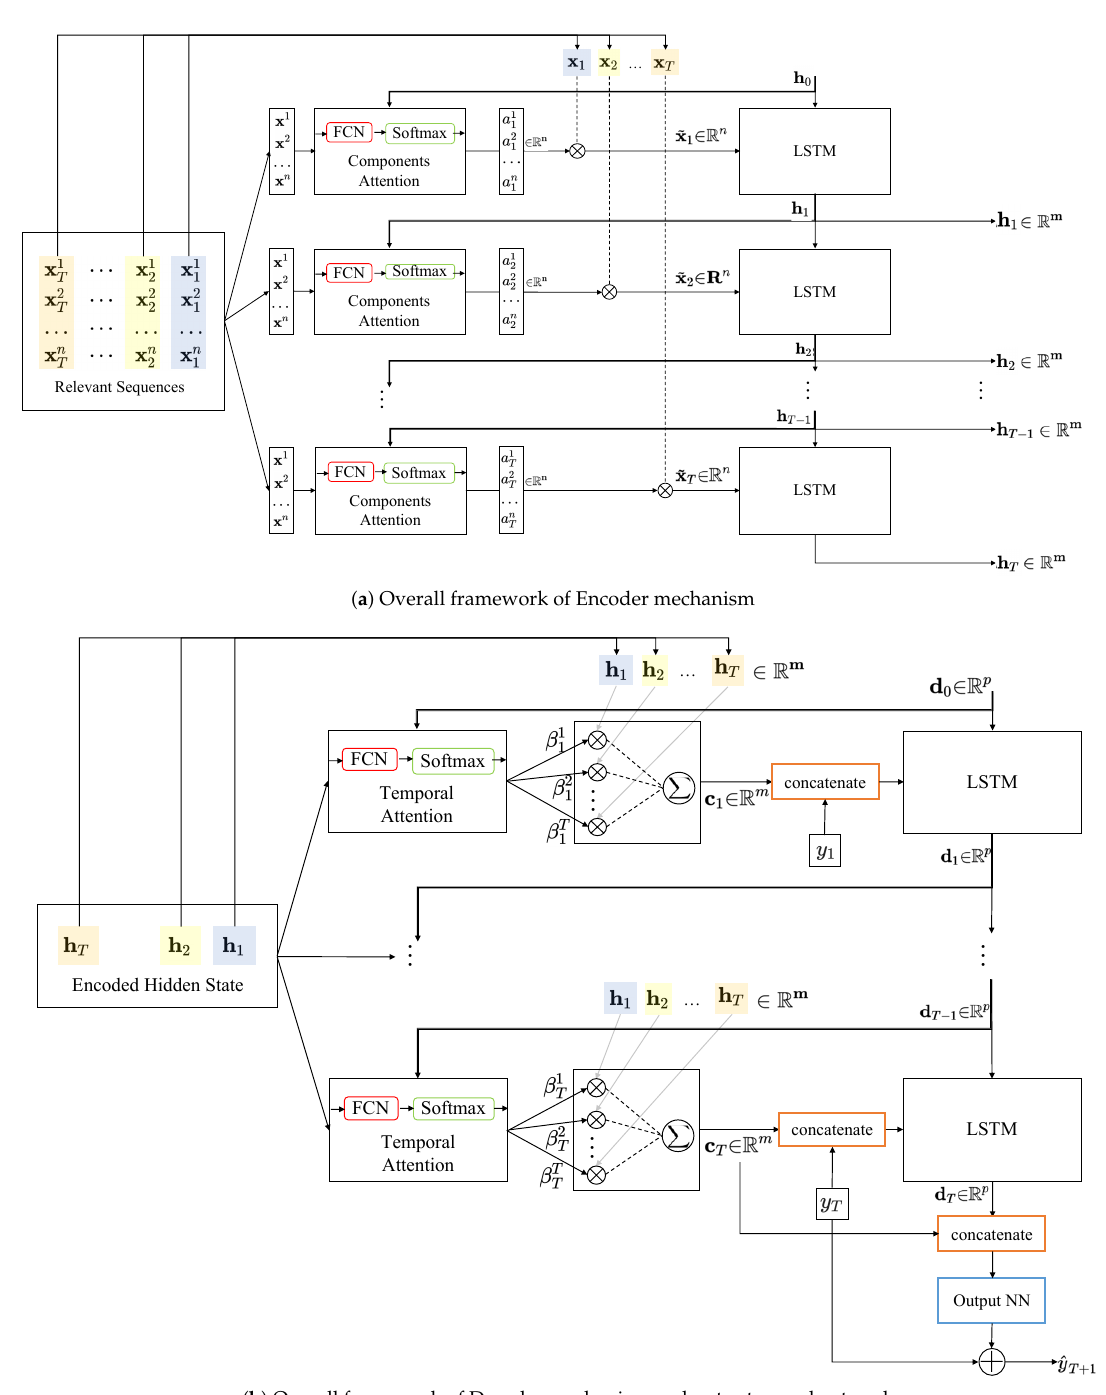
Figure 3. The proposed model consists of three parts: encoder, decoder, and a fully connected neural network for final predicting. The output of the encoder mechanism is the input of the decoder mechanism. Encoder is employed to embed the history series to encoded features h t , which are inferred from a Lstm mechanism in encoder module. Then, the encoded features will be decoded by decoder module and produce new hidden state d t . The third neural network estimates the difference between y t + 1 and y t from d t and another context features c t . ( a ) Overall framework of Encoder mechanism; ( b ) Overall framework of Decoder mechanism and output neural